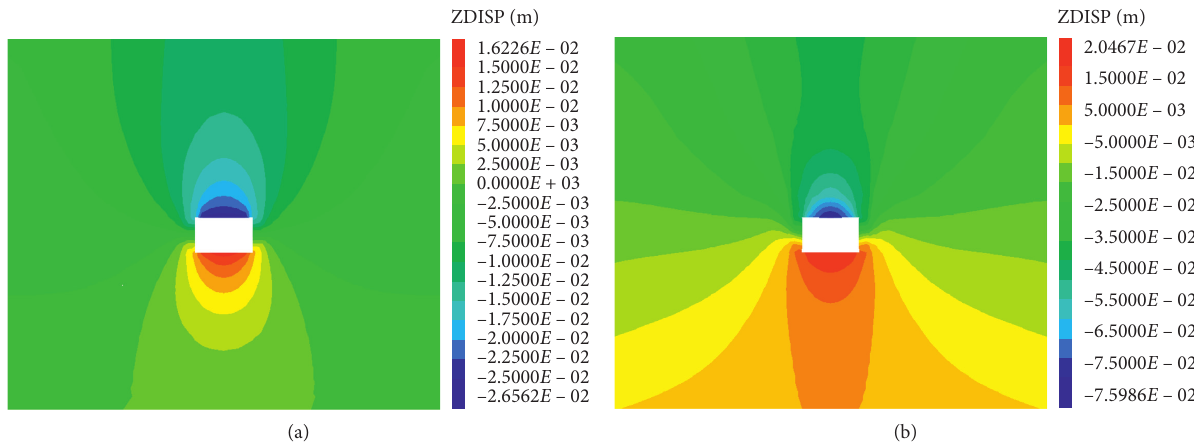
Figure 9: Distribution of the plastic zone of the surrounding rock (a) before applying disturbance load and (b) after applying disturbance